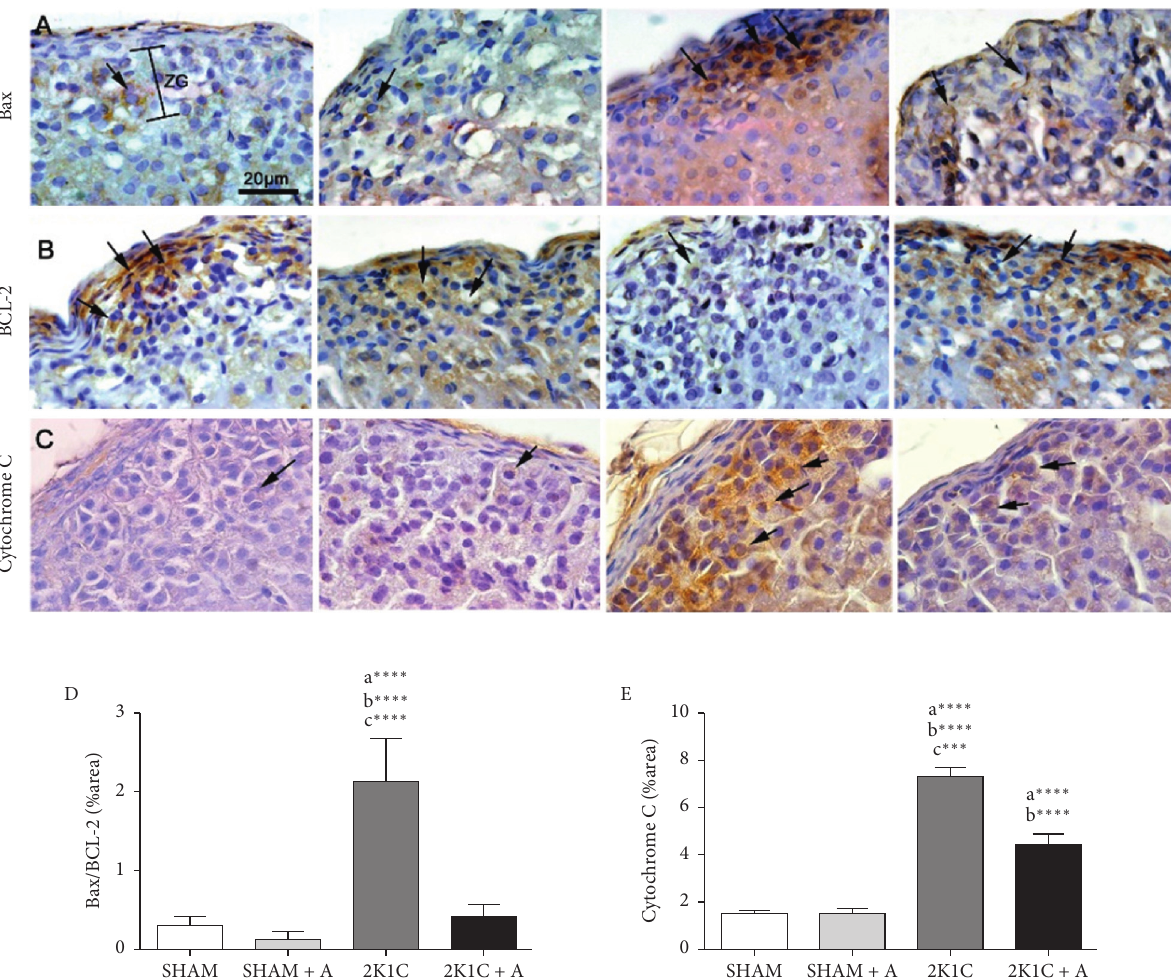
Figure 4: Detection and quantification of Bax, BLC-2, and cytochrome C expression in the zona glomerulosa. (A–C) Photomicrographs of all experimental groups are presented stained with anti-Bax, anti-BCL-2 and anticytochrome antibodies, respectively. (D-E), quantification of Bax and BLC-2 ratio and cytochrome C proteins are shown, respectively. ZG, zona glomerulosa. Arrows indicate the immunostained positive cells. (a) represents ≠ to the SHAM group, (b) represents ≠ to the SHAM+A group, and (c) represents ≠ to the 2K1C +A group. ∗∗∗∗ p < 0 . 0001; ∗∗∗ p < 0 . 001. n � 10 for all experimental